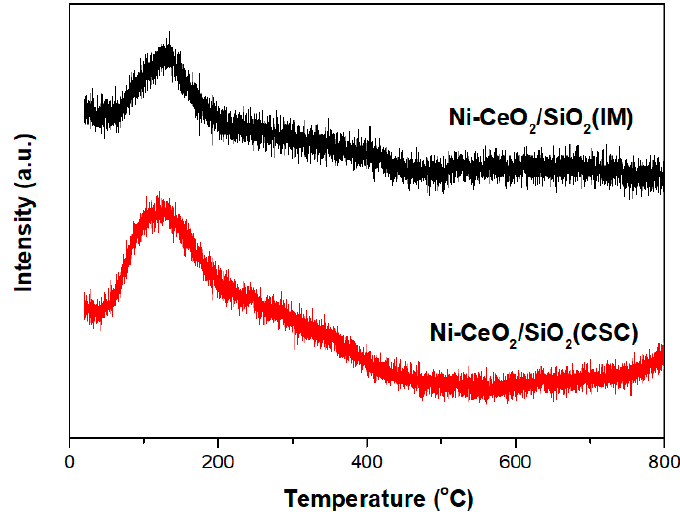
Figure 5. CO 2 temperature-programmed desorption (CO 2 -TPD) profiles of the Ni-CeO 2 /SiO 2 (CSC) and Ni-CeO 2 /SiO 2 (IM) catalysts .